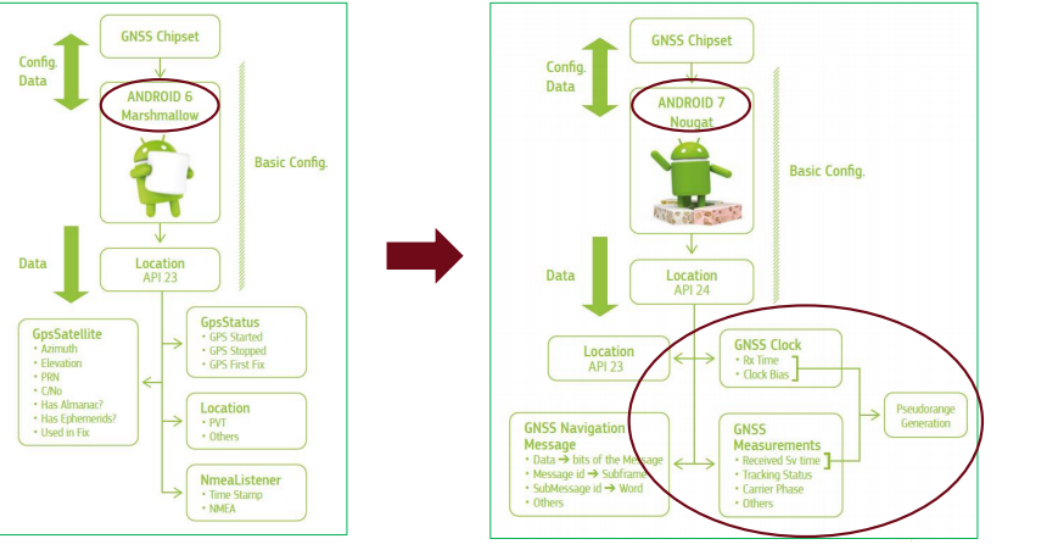
Figure 1. From Location API 23 to Location API 24. PVT: Position-Velocity-Time. NMEA: National Marine Electronics Association. C/No: Carrier-to-Noise